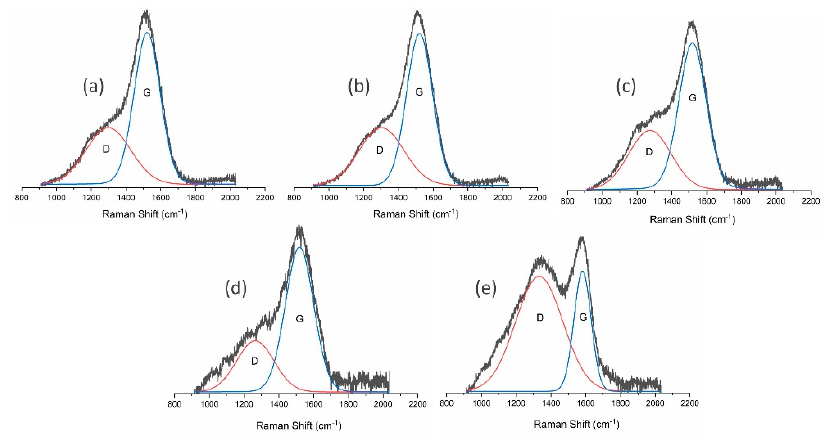
Figure 2. Raman spectra of powder produced using ( a ) methane; ( b ) methane and hydrogen mixture; ( c ) methane and argon mixture; ( d ) methane and oxygen mixture; and ( e ) methane and nitrogen mixture. Table 2. Analysis of Raman spectra of produced carbon flakes.